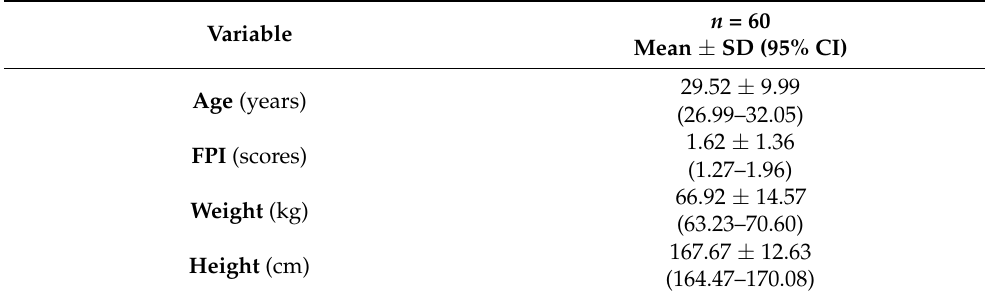
Figure 4. A flowchart about the handling of the different intervention groups. Table 2. Anthropometric characteristics of the